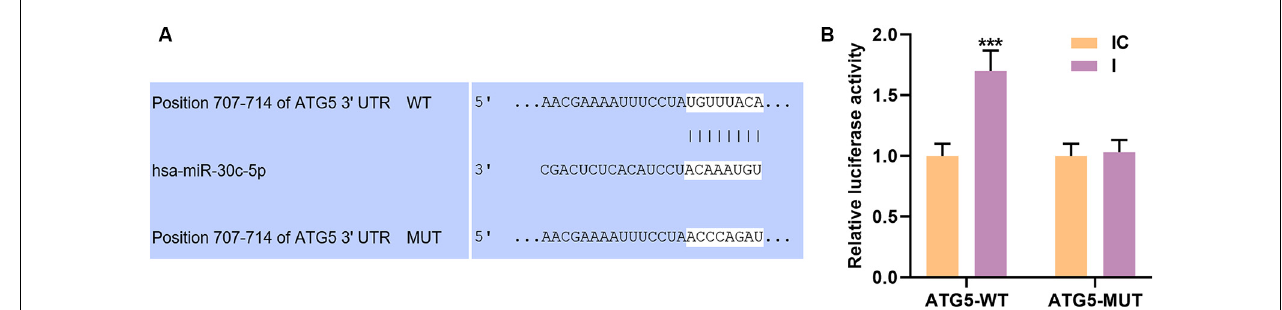
FIGURE 5 | Autophagy-related gene 5 protein (ATG5) was a target gene of miR-30c-5p. (A) The potential binding site of miR-30c-5p on the 3’UTR of ATG5 was obtained using TargetScan. (B) Dual-luciferase reporter assay was performed on SH-SY5Y cells to assess the targeting relationship between ATG5 and miR-30c-5p. IC: inhibitor control. I: miR-30c-5p inhibitor. *** p < 0.001 vs.